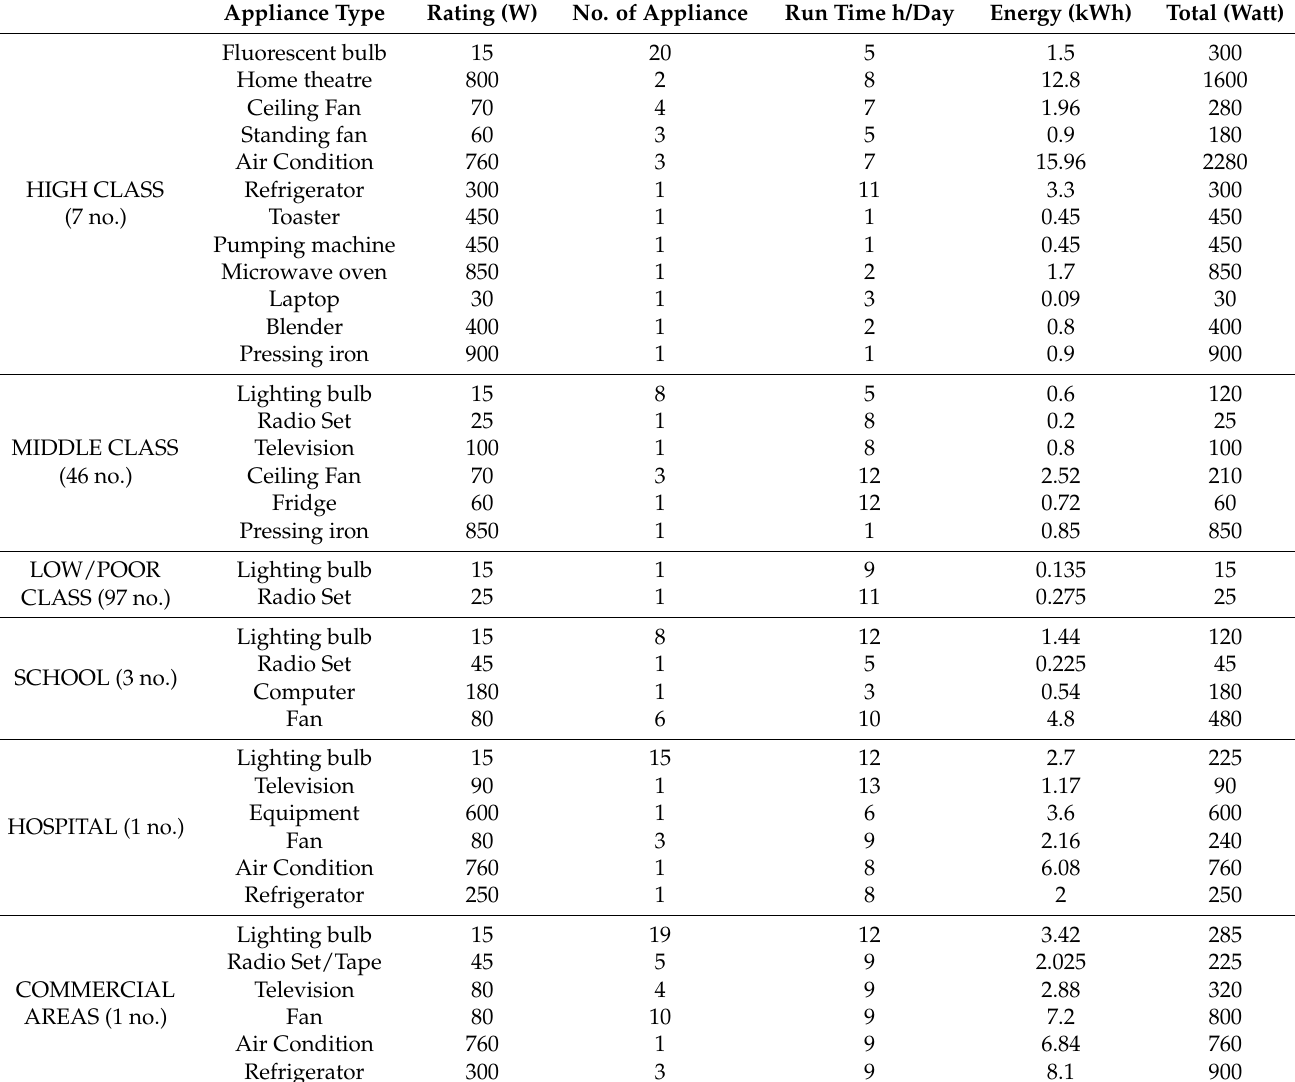
Table 2. Electric loads in Okorobo-Ile